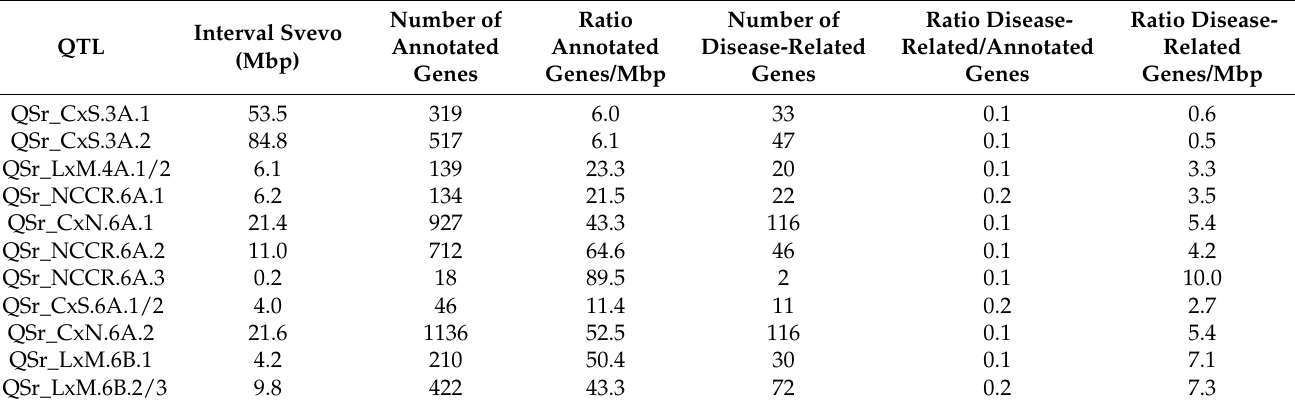
Table 5. Size and gene content of the physical regions corresponding to the QTLs for stem rust resistance identified in the present